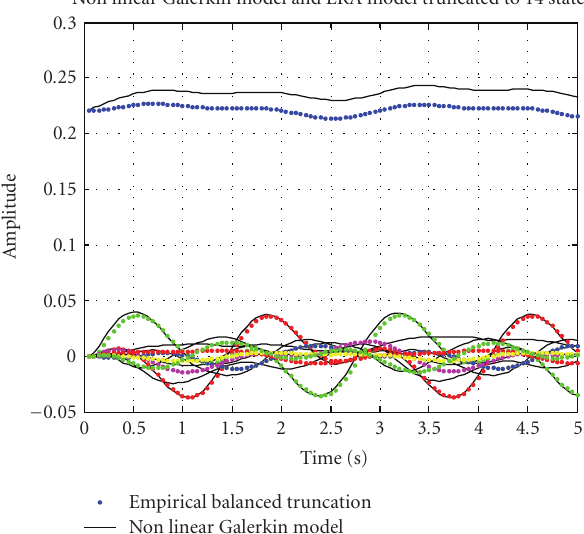
Figure 6: Projected and POD model coe ffi cients.